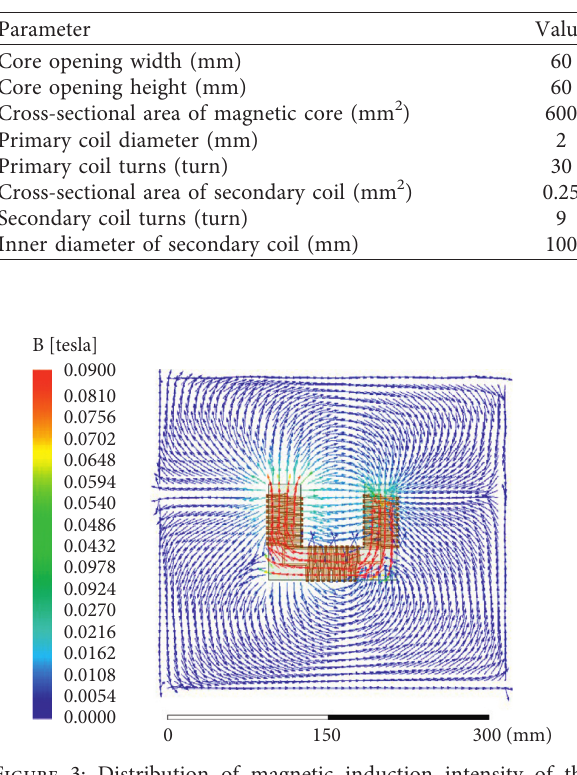
Table 2: System parameters.